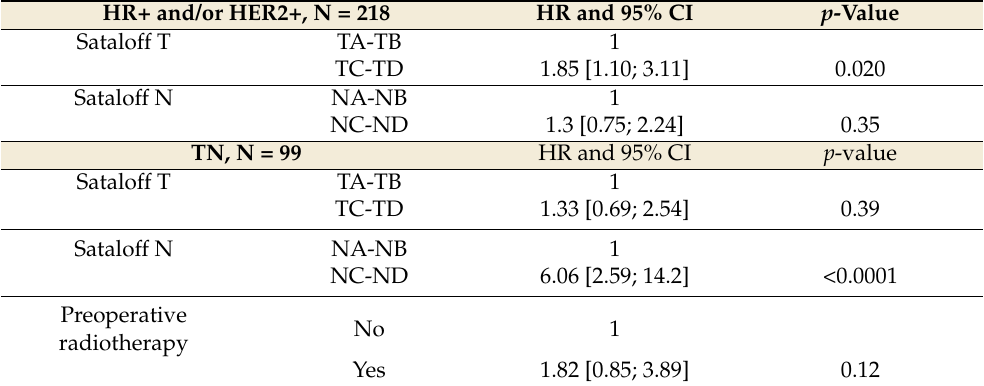
Table 4. Multivariate analyses of prognostic factors for disease-free survival (DFS) stratified by triple-negative